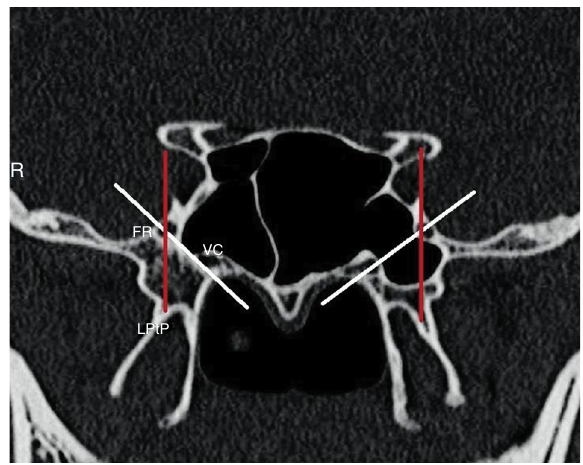
Figure 3 Sphenoid sinus pneumatization classification according to the imaginary line connecting foramen rotundum to vidian canal; white lines (right, lateral recess; left, tangent) and position of the FR regarding to base of lateral pterygoid plate; red lines (right and left, online) (R, right). SS pneumatization was classified according to the imagi- nary line connecting FR to VC (Fig. 3): Lateral recess --- when the sinus is pneumatized to the lat- eral of the imaginary line;